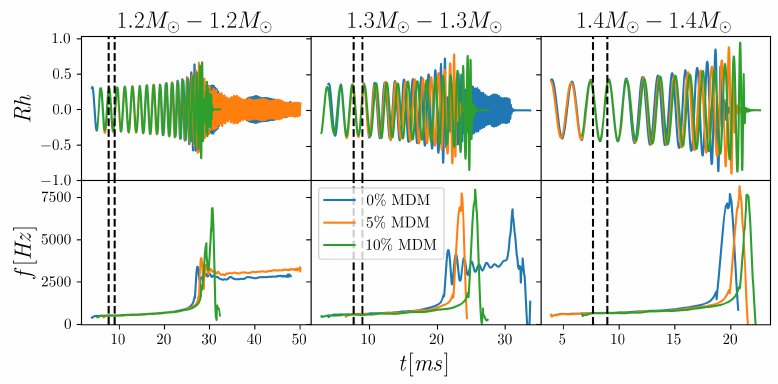
Figure 4. Waveform strain and frequency of the (cid:96) = | m | = 2 GW mode for all simulations. Each plot contains simulations with the neutron star mass combination listed at the top of the column. The colors represent the different mirror dark matter fractions. All simulations with the same total mass are aligned during the first few orbits of the simulation time. Black dashed lines mark the time interval where the waveform alignment